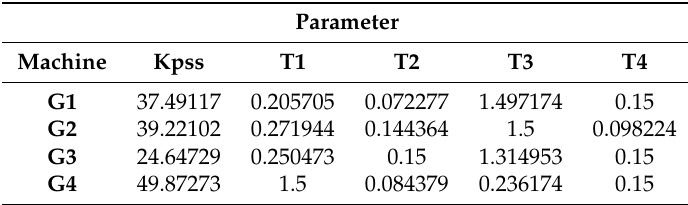
Table 4. Optimal parameters for system